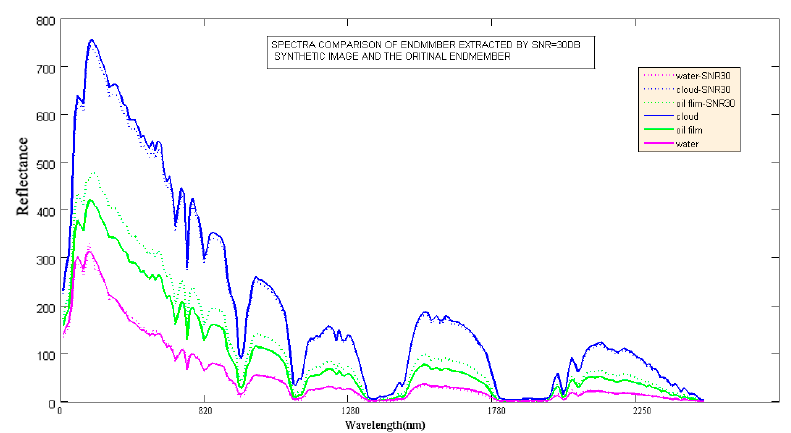
Figure 16. Comparison of endmembers (SNR = 30 dB) .